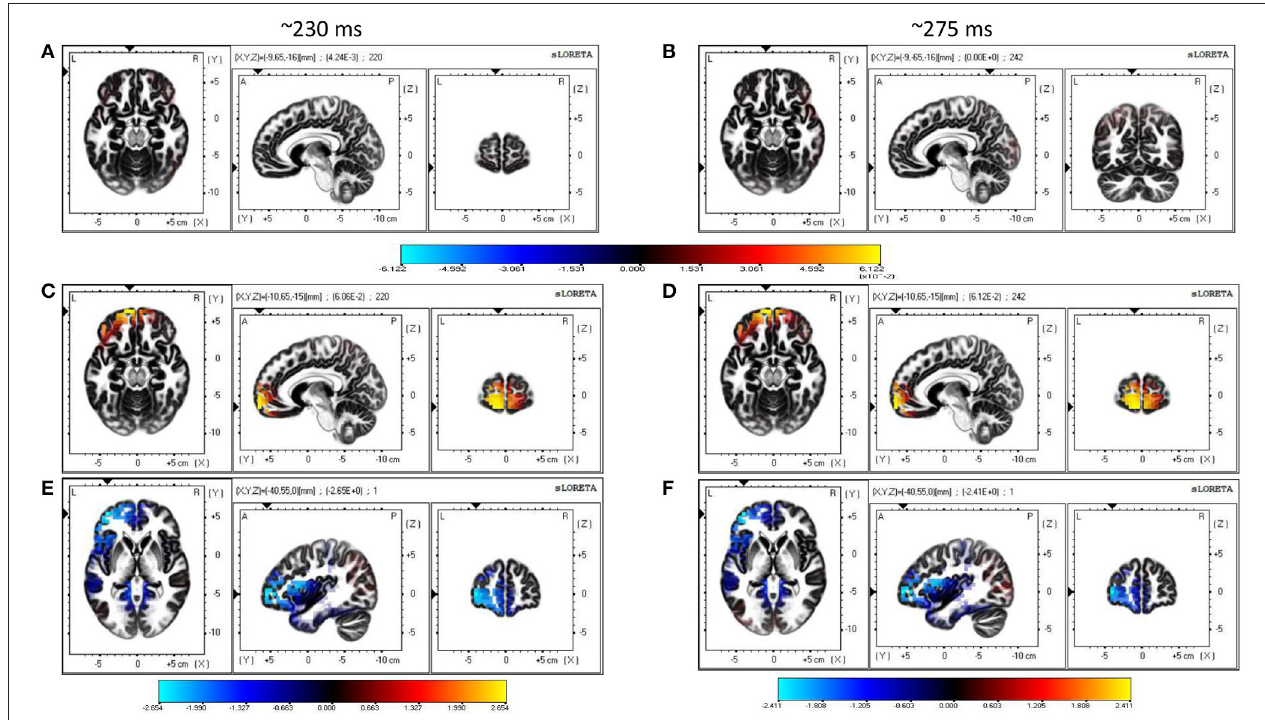
FIGURE 5 | Source Reconstruction. (A,B) Show sources estimated at 230 and 275 ms using sLORETA software for trials with concurring cues. (C,D) Show sources estimated at 230 and 275 ms using sLORETA software for trials with conflicting cues. The color bar depicts the squared magnitude of the current density [ µ A 2 / ( mm 4 . Hz )]. (E,F) Are maps of non-parametric statistics comparing concurring and conflicting trials during the 200–250 and 250–300 ms time windows. Non-parametric analysis was performed using one-tailed F-ratio test (concurring < conflicting) on paired data. Color bar represents value of log F-ratio for each voxel.